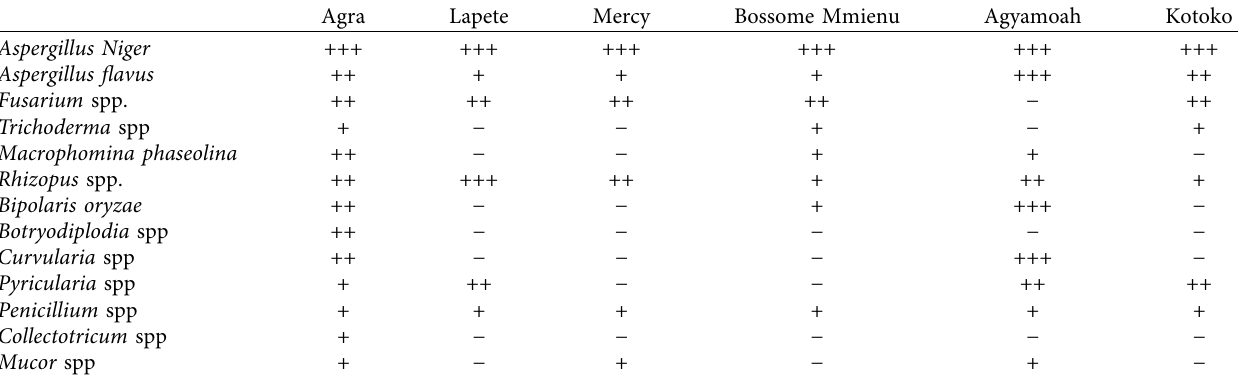
Table 7: Fungi identifed on rice seed varieties collected from the three selected districts tested by the blotter method. Agra Lapete